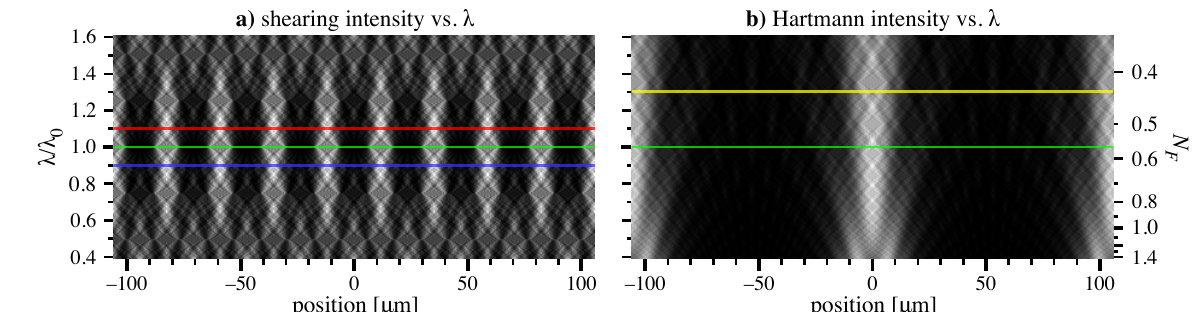
Figure 4. Coherent wave-propagation models of shearing and Hartmann detector-plane intensities for a range of wave- lengths about λ 0 = 2nm (green line), in a converging beam. Each row is normalized for constant integrated power. Pitch values are d = 25.469µm for shearing and D = 114.609µm for Hartmann with a = 38.203µm. ( a ) Red and blue reference lines represent a ± 10% wavelength change. ( b ) Hartmann calculations show separation between neighboring beamlets. The yellow line marks a +30% wavelength change, where β = 0.690. The corresponding Fresnel number is shown at the